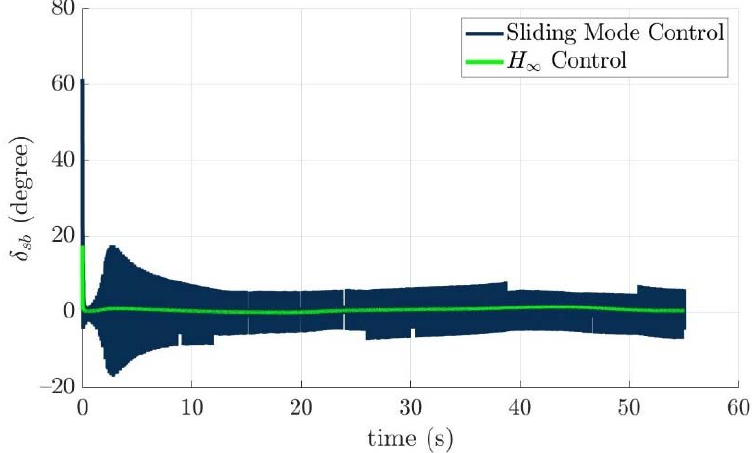
Figure 26. The starboard bow fin angles of the controlled torpedo-like underwater vehicle for two control laws, respectively.